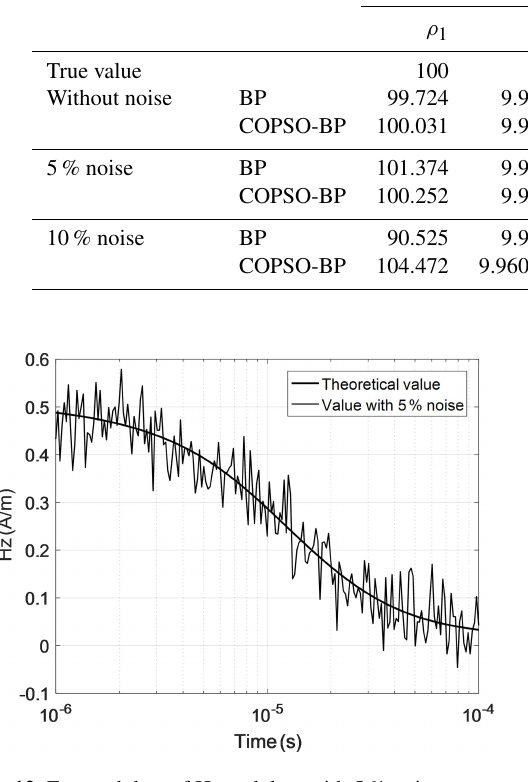
Figure 12. Forward data of Hz and data with 5%